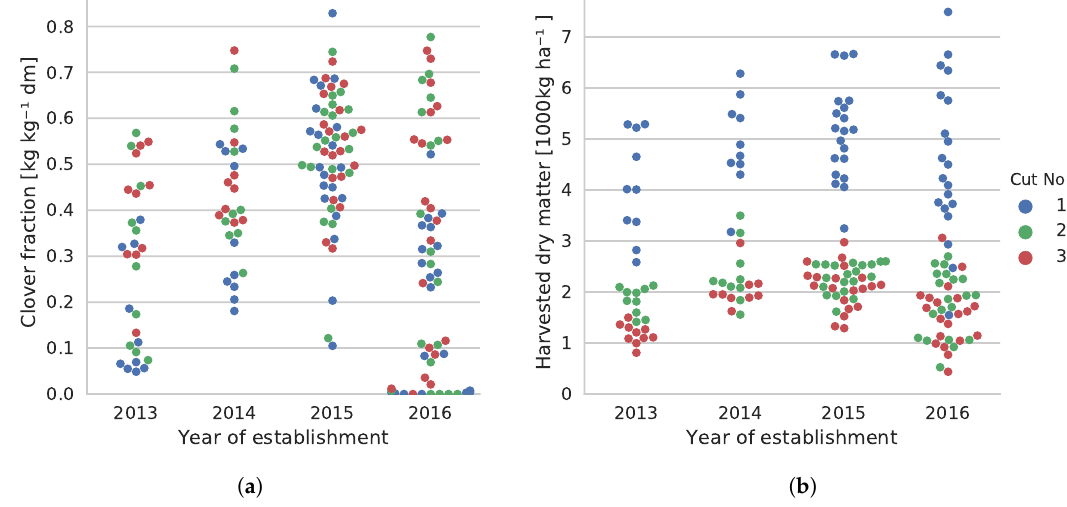
Figure 2. Overview of the variation in the 179 sample pairs sorted by the age of the swards. ( a ) Clover content in harvested material; ( b ) The total dry matter yield of harvested samples. The year axis is discrete, but points are spread out to avoid occlusion of samples.